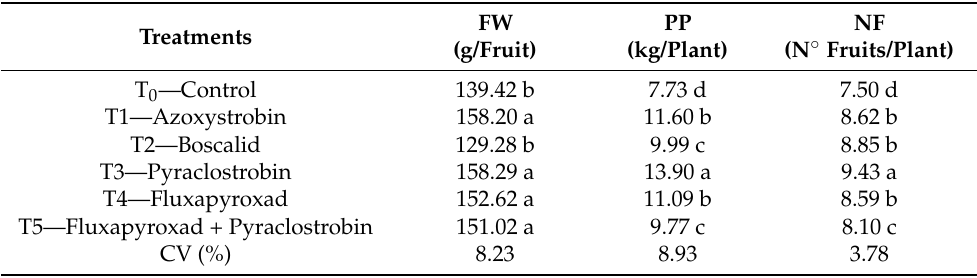
Table 4. Fruit weight (FW), production per plant (PP) and number of fruits (NF) of tomato plants treated with physiological effect fungicides.